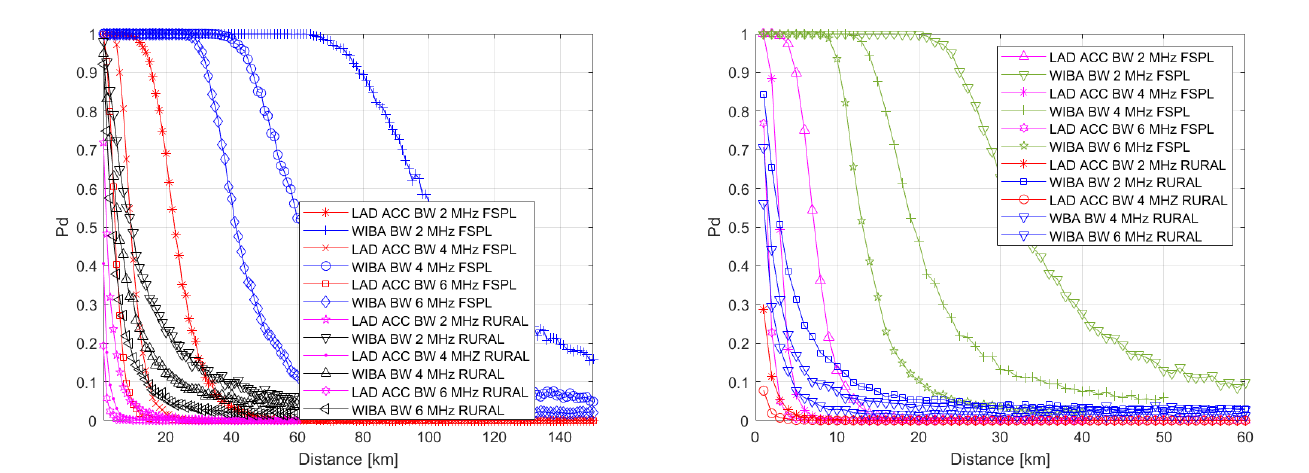
Figure 11. P vs. detection distance when transmit power of the d signal is 30 dBm. FSPL and rural channel.